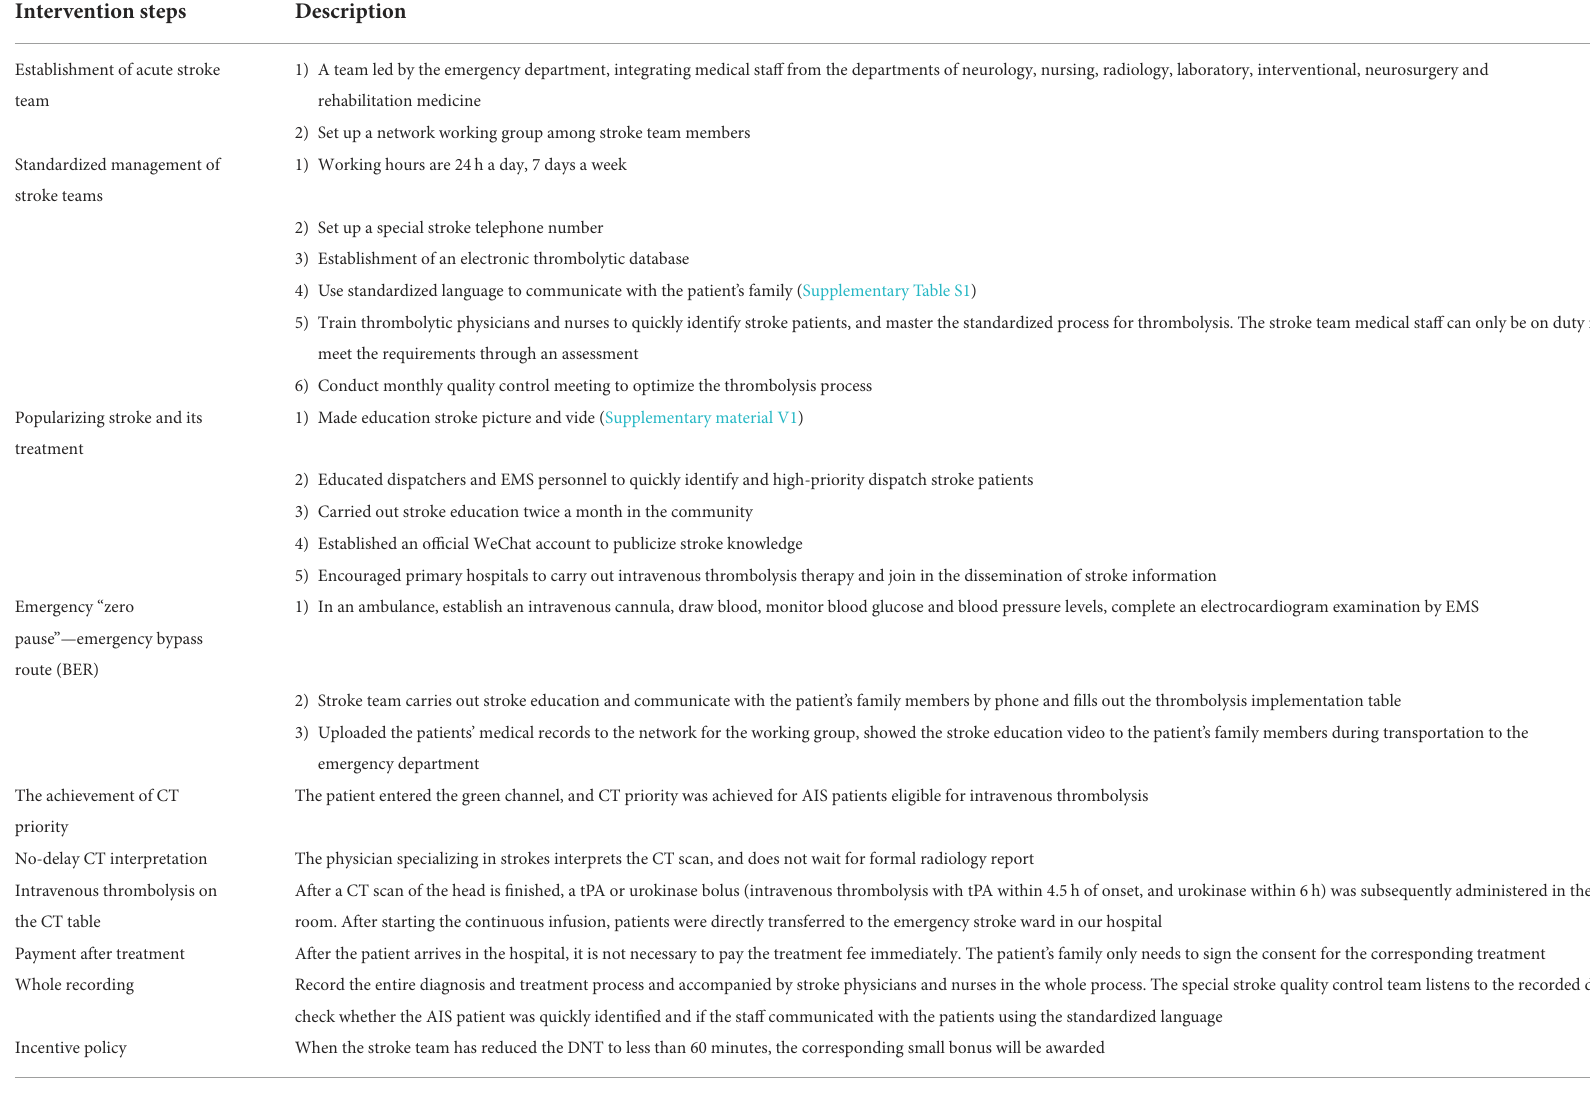
TABLE 1 Systemic interventions incorporated into the standard operating